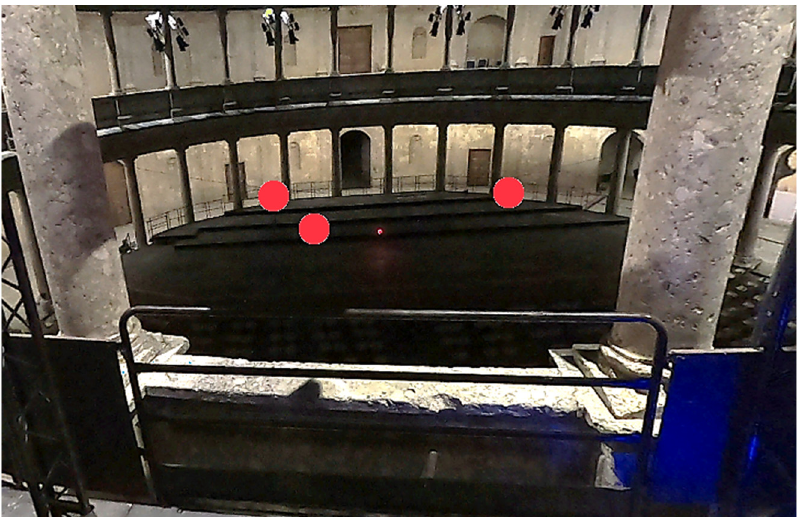
Figure 12. View from P9 featuring A, B and C positions.